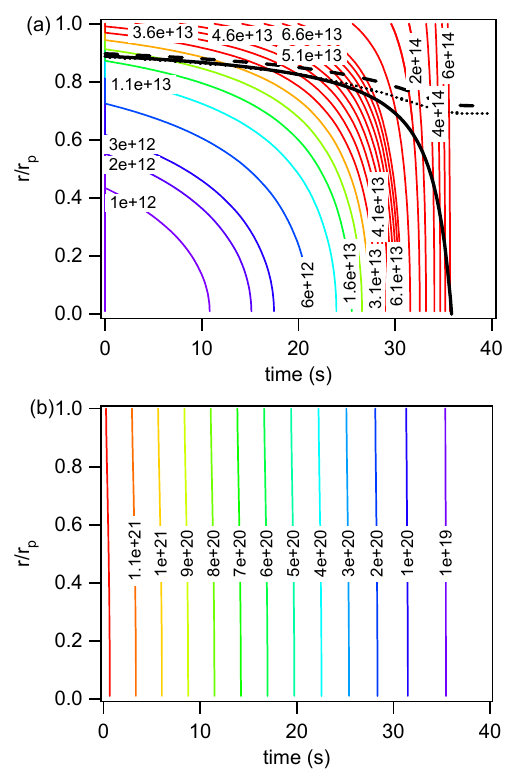
Fig. 4. (a) Loss rate ( L b ) and (b) absolute loss rate ( L ∗ ) of oleic b k acid in the bulk calculated by KM-SUB for bulk layers 1 (near- surface bulk), 20, 40, 60, and 100 (core) in BC1. L b calculated /V b ) calculated by KM- by K2-SUB and volume average L b ( = L ∗ b ) calculated SUB are shown in panel (a). Total absolute los rate ( L ∗ b by KM-SUB and K2-SUB are also shown in panel . b